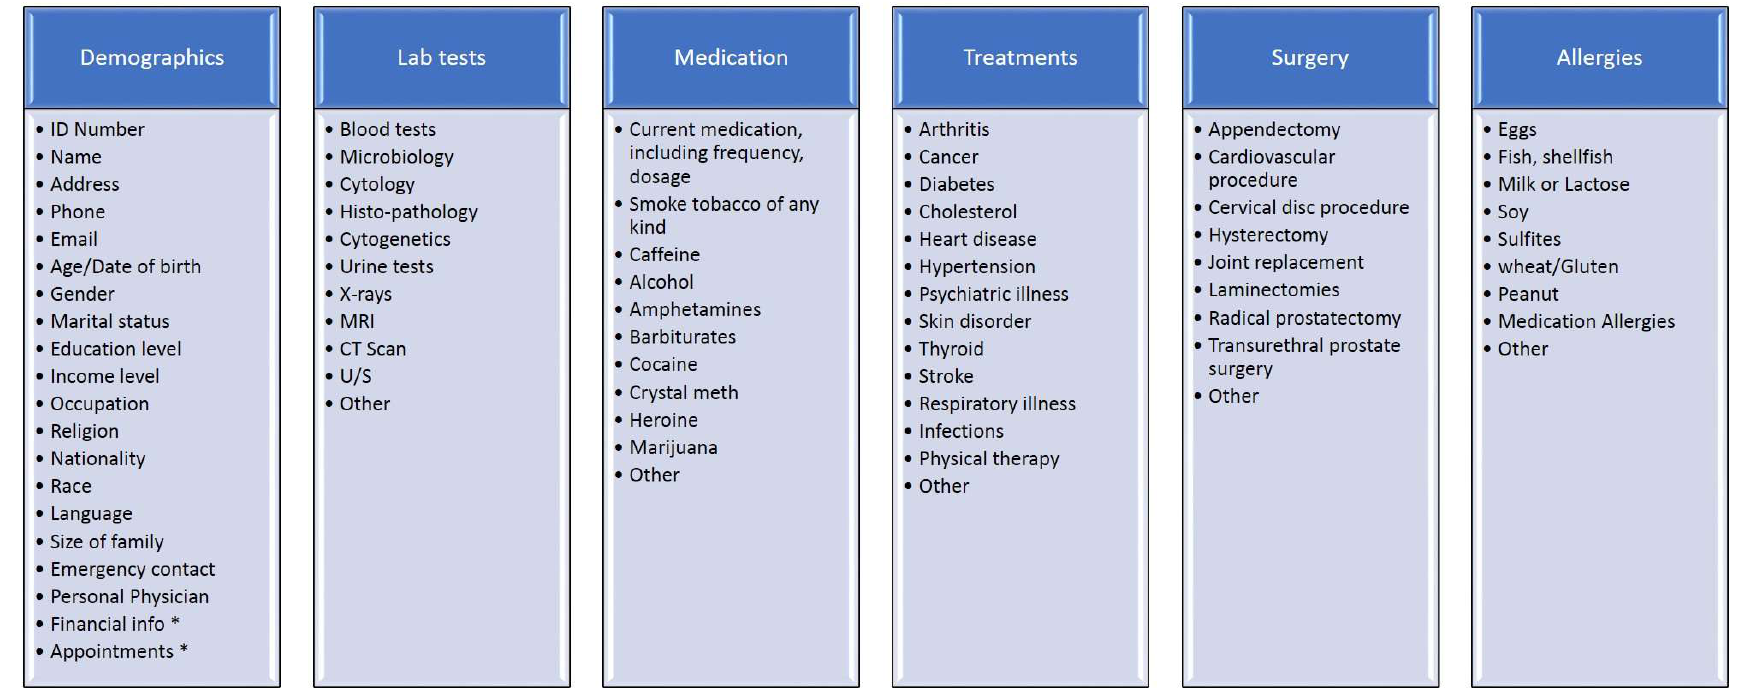
Figure 1. A Contents and structure of EMR system.